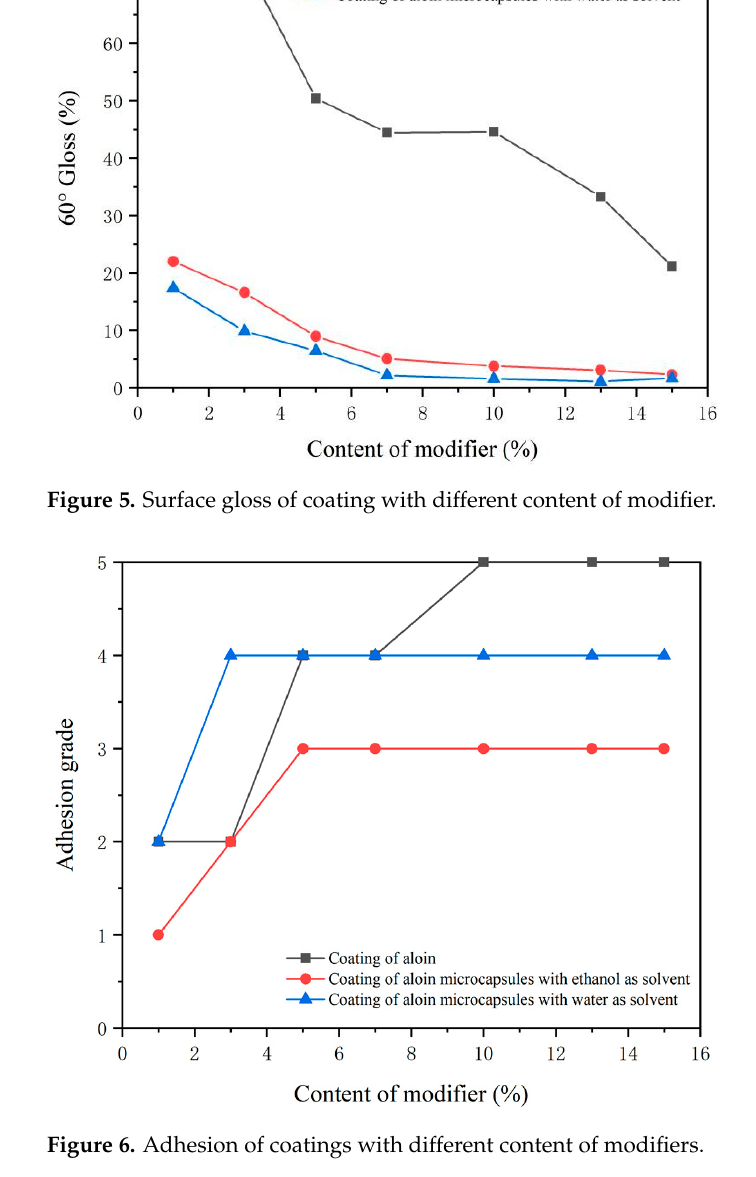
Figure 5. Surface gloss of coating with different content of modifier.